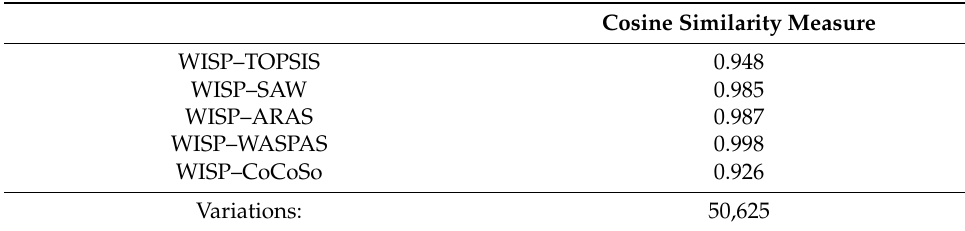
Table 13. The correlation between the best-ranked